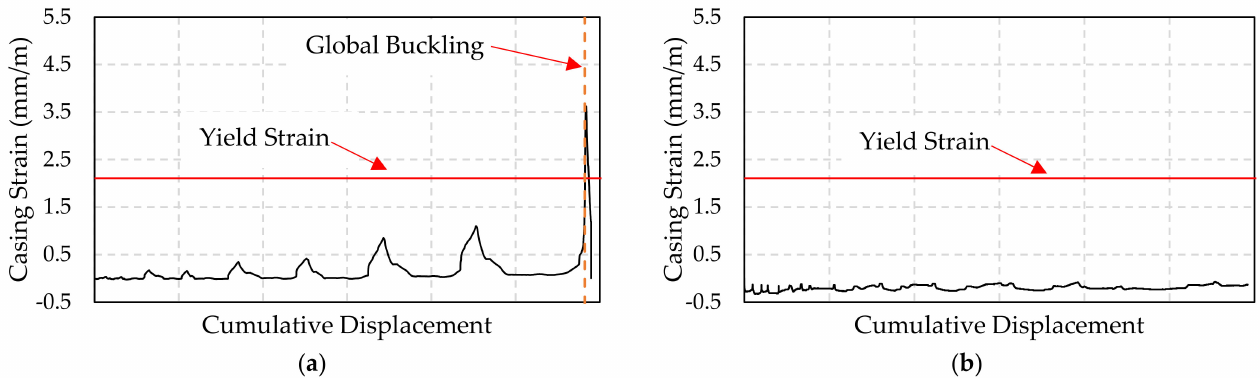
Figure 10. Typical casing longitudinal strain: ( a ) specimens that failed by global buckling; ( b ) specimens with no global